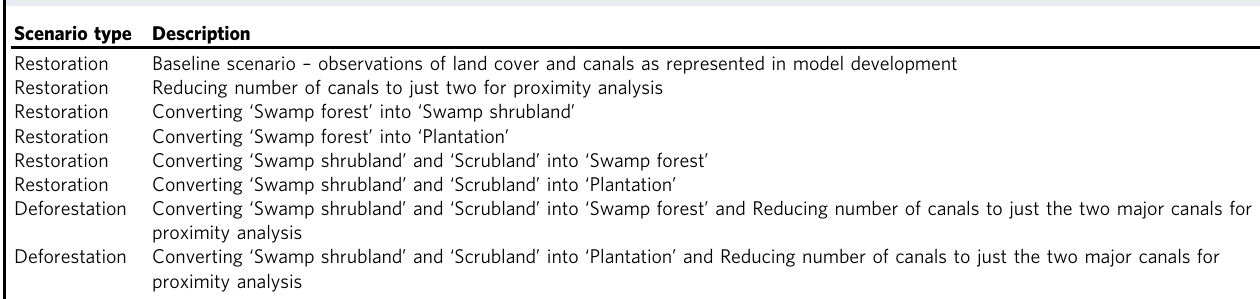
Table 2 Future scenario types and